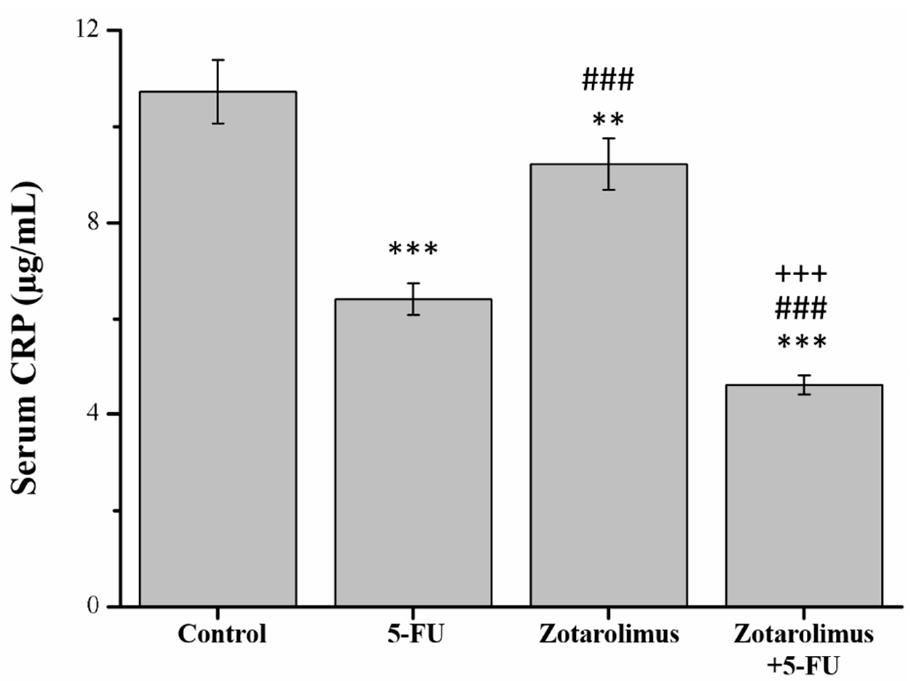
Figure A3. Changes in the serum levels of CRP measured in BALB/cByJNarl mice given different treatments, including control, 5-FU (100 mg/kg/week), zotarolimus (2 mg/kg/day), and zotarolimus (2 mg/kg/day) combined with 5-FU (100 mg/kg/week). All data are presented as mean ± standard deviation, n = 7 per group. ** p < 0.01 and *** p < 0.001 compared with the control group. ### p < 0.001 compared with the 5-FU-treated group. +++ p < 0.001 compared with the zotarolimus-treated group.